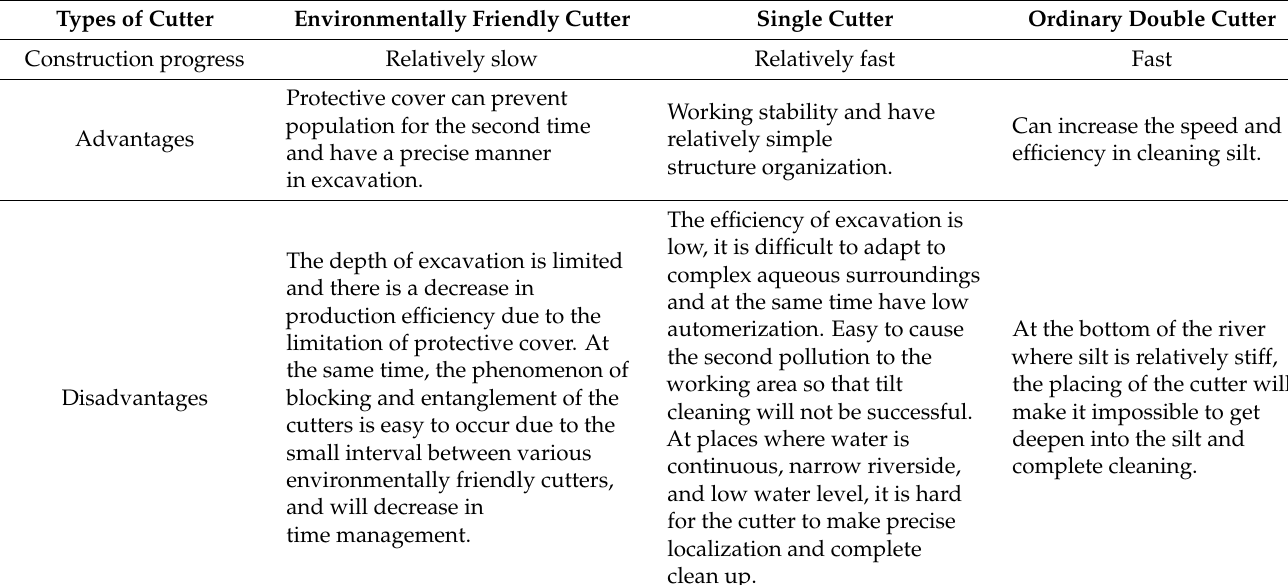
Table 1. Comparative analysis of the advantages and disadvantages of existing